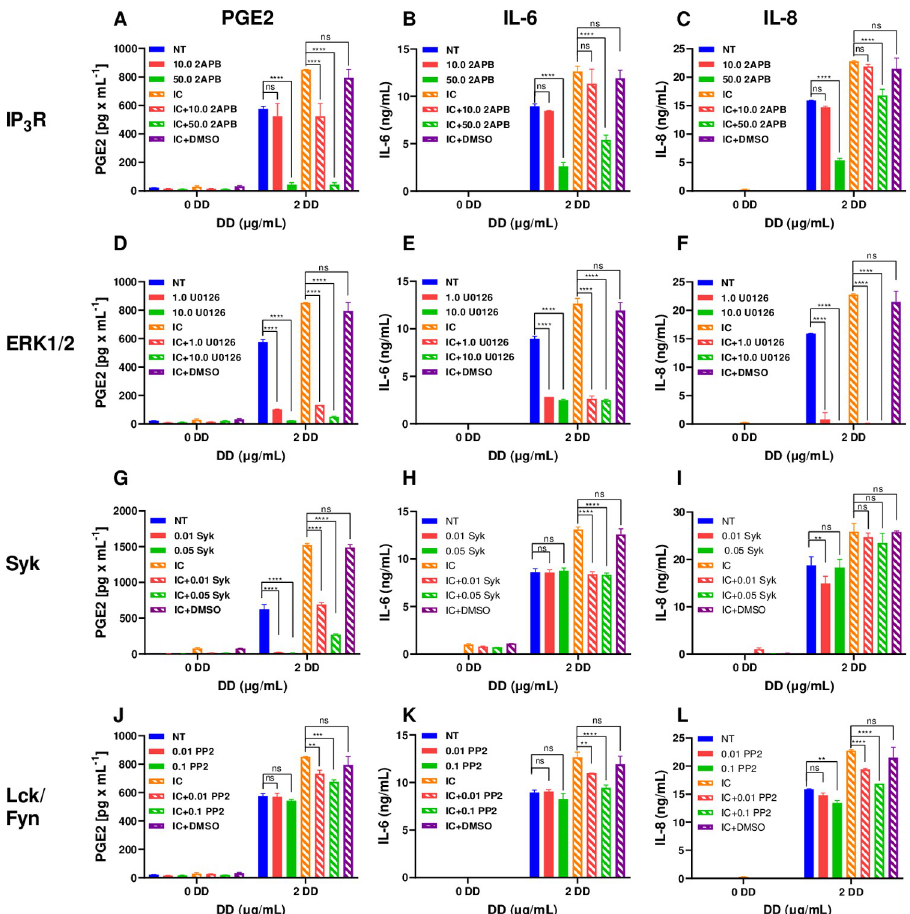
Fig 3. Inhibition of cytosolic [Ca2+], MAPK, and Syk protein tyrosine kinase differentially reduced production of PGE2, IL-6, and IL-8 in human monocytes activated with spike-IgG IC in the presence of DD. Monocytes were left not treated (NT in A-L) or were treated with inhibitors: inhibitor of InsP 3 R (2-ABP at 10 or 50 μ M, A-C), inhibitor of ERK1/2 (U0126 at 1.0 or 10 μ M, D-F), inhibitor of Syk kinase (PRT062608 at 0.01 or 0.05 μ M, G-I), inhibitor of Lck/ Fyn (PP2 at 0.01 or 0.1 μ M, J-L), or with DMSO in control (A-L) and were incubated with rS+S-cIgG IC (IC) with DD at 2 μ g/ml or with DD alone. Cell culture supernatants were collected and PGE2 (A, D, G, and J), IL-6 (B, E, H, and K), and IL-8 (C, F, I, and L) concentrations were determined by FRET assay (A, D, G, and J) and by ELISA (B, E, H, and K for IL-6 and C, F, I, and L for IL-8). Mean PGE2 and IL-6 and IL-8 concentrations ± SD calculated for triplicate wells are shown for a representative of three experiments performed with cells from individual donors. �� P � 0.001, ��� P � 0.0001, by two-way ANOVA using Tukey’s multiple comparison test.